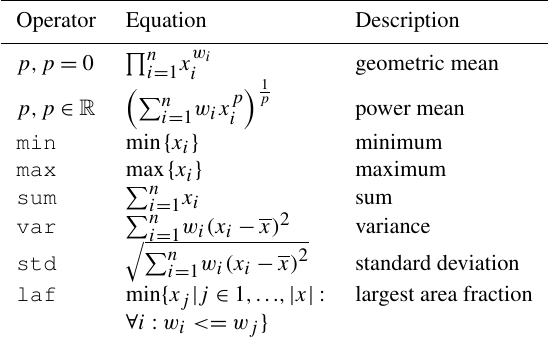
Table E2. Table of operators that can be specified in a string for the property upscale_ops in the configuration file mpr.nml . The values x of the array with size n (with indices i ) are passed to the operator with weights w of the same